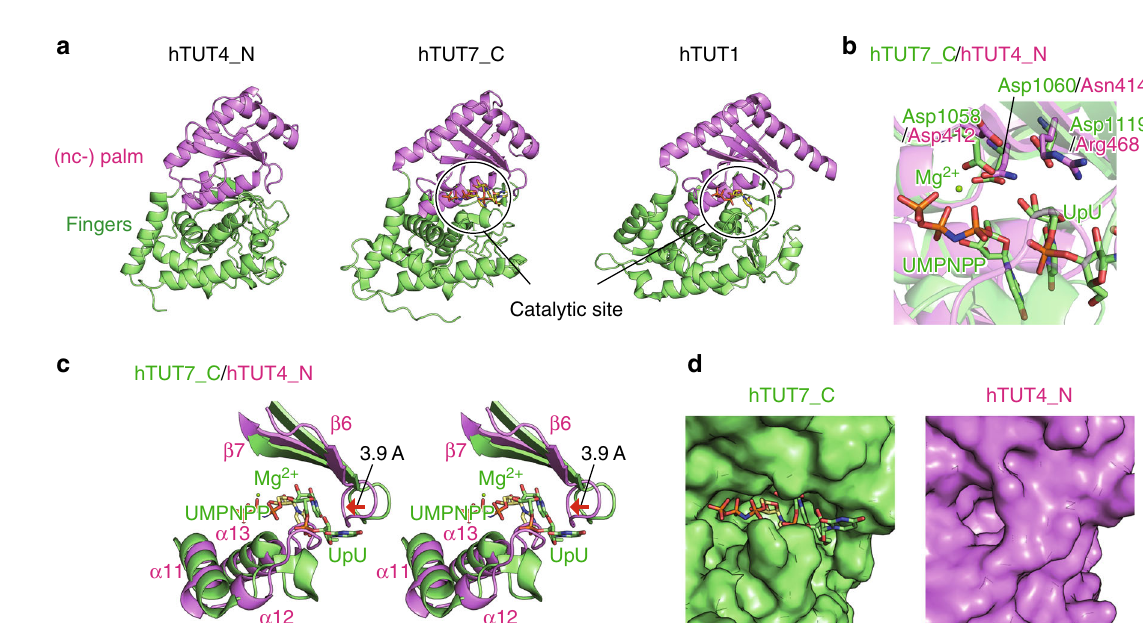
Fig. 2 Non-catalytic palm and fi ngers from the LIM of human TUT4. a Comparison of the palm and fi ngers domains of human TUT4 (amino acid residues 344 – 723; left) with those of human TUT7_C 23 (PDB ID: 5W0N, amino acid residues 985 – 1344; middle) and human TUT1 41 (PDB ID: 5WU3, amino acid residues 145 – 599; right). b Superimposition of the structures of the catalytic centers of hTUT7_C (green) and hTUT4_N (magenta). The catalytic triad of hTUT7_C and the corresponding residues of hTUT4_N are shown in stick models. c Structures of the catalytic pocket of hTUT7_C and the corresponding region of hTUT4_N. d Surface models of the catalytic pockets of hTUT7_C (left) and hTUT4_N (right)